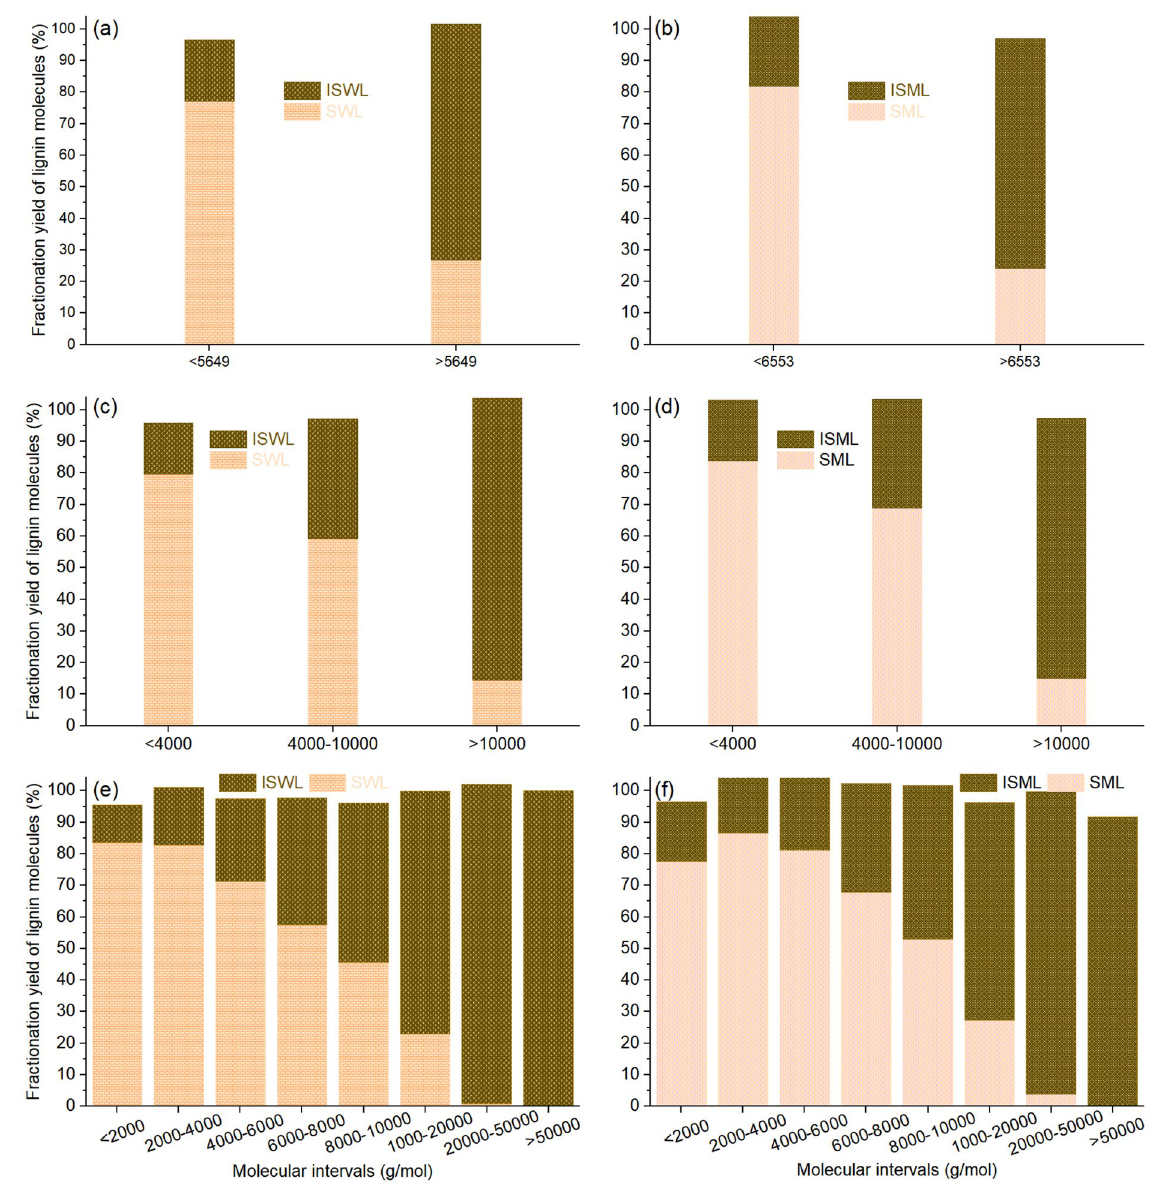
Figure 3. Fractionation yields of molecules belonging to different molecular intervals: SWL and ISWL under ( a ) 2, ( c ) 3, and ( e ) 8 intervals; SML and ISML under ( b ) 2, ( d ) 3, and ( f ) 8 and R SML → Mw - max ) were 1.95 and 0.58, respectively (Fig. 4a). The ratios corresponding to the yield of ISML ( R ISML → min − Mw and R ISML → Mw - max ) were 0.43 and 1.25, respectively (Fig. 4a). The easier dissolution of the small molecules was validated 23,24 . More importantly, this is the first time that a quantitative method to calculate the fractionation yield of the lignin molecules has been proposed. More than 10% difference in the molecule contents of the parent lignin and their fractions was observed under 3 intervals (Fig. 2c and d). For example, the molecule contents corresponding to WL, SWL, and ISWL were 19.6%, 37.3%, and 5.4% under the interval of min–4000 g/mol, respectively; 33.0%, 46.5%, and 21.6% under the interval of 4000–10,000 g/mol, respectively; and 47.4%, 16.3%, and 73.0% g/mol under the interval of 10,000–max g/mol, respectively (Fig. 2c). Under eight intervals, WL, SWL, and ISWL showed similar molecule contents of 9.40%, 10.2%, and 8.20%, respectively, under the interval of 8000–10,000 g/mol (Fig. 2e). This indicates that WL belonging to the interval of 8000–10,000 g/mol has little influence on fractionation. This conclusion was reached when the molecules were divided into eight intervals instead of two or three. This fully reflects the advantage of the integral method. This conclusion cannot be drawn by studying the differences in the Mn, Mw, and PDI values recorded for the parent lignin molecules and the fractions. Interestingly, the contents of ML, SML, and ISML were similar and in the range of 6.62–9.92% under the interval of 8000–10,000 g/mol (Fig. 2f). There- fore, molecules of ML in the interval of 8000–10,000 g/mol have little effect on fractionation. This observation